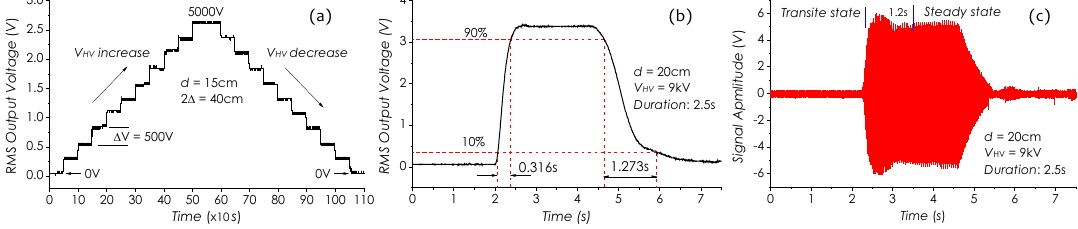
Figure 15. Dynamic responses of detection system, tested with ( a ) a 500-V step voltage, ( b ) a 9-kV pulse AC voltage. ( c ) is an E -field signal waveform under a 9-kV pulse AC voltage